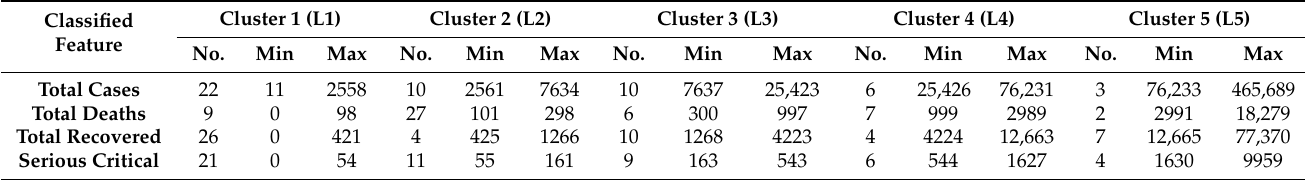
Table 2. The statistical description for the clusters of classified features.